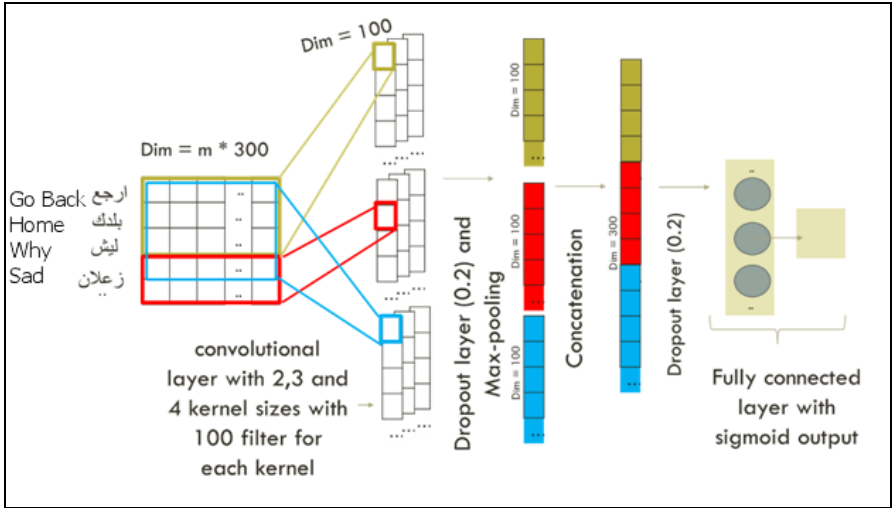
Figure 1. Convolutional neural network (CNN) architecture.